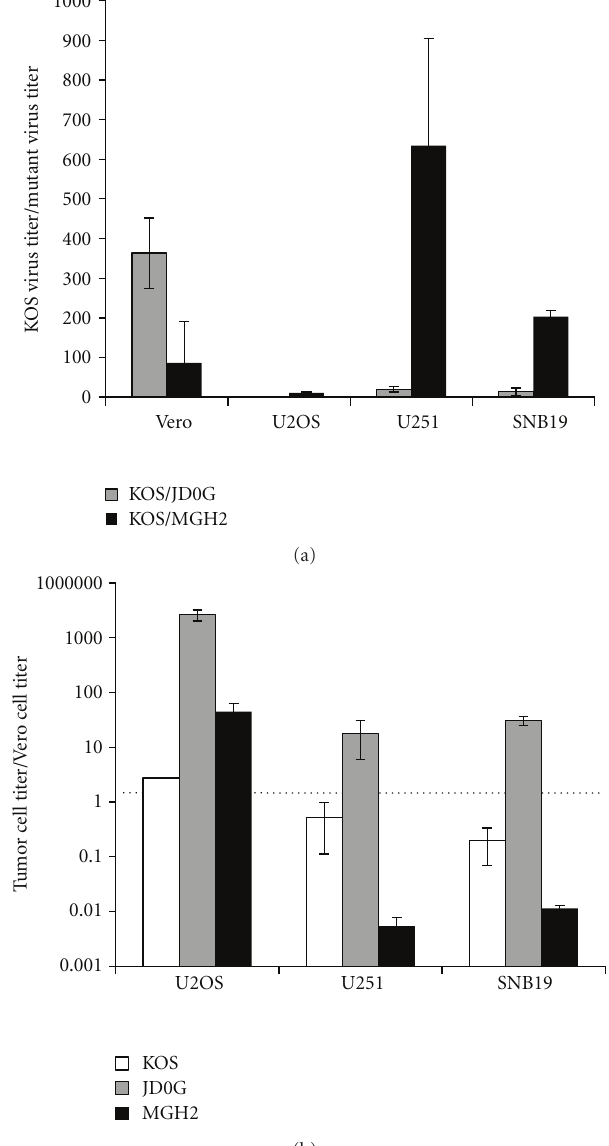
Figure 2: JD0G infection of glioblastoma cells results in e ffi cient virus replication and tumor-selective cell death. (a) The replication of JD0G was evaluated in comparison to KOS and MGH2. HEL, U251, and SNB19 cell lines were infected in parallel with KOS, MGH2, or JD0G at an MOI of 0.1 based on U2OS titers. Supernatants were collected at 24 hpi, and the amount of virus produced was assessed by titration on U2OS cells. The data represent the average of three independent infections, and error bars represent the standard deviation. For all three viruses the di ff erences in virus yield observed between HEL cells and either glioma cell line are statistically significant as determined by the student t -test ( P values less than 0.03). (b) Tumor-specific cell death was assessed by counting the number of surviving cells following infection with either JD0G or MGH2 virus. HEL, U251 or SNB19 cells were infected at an MOI of 0.1, and Trypan Blue staining was performed to count the number of viable cells 48h postinfection. The data represent the average of three independent infections, and error bars represent the standard deviation. All di ff erences are statistically significant ( P values less than